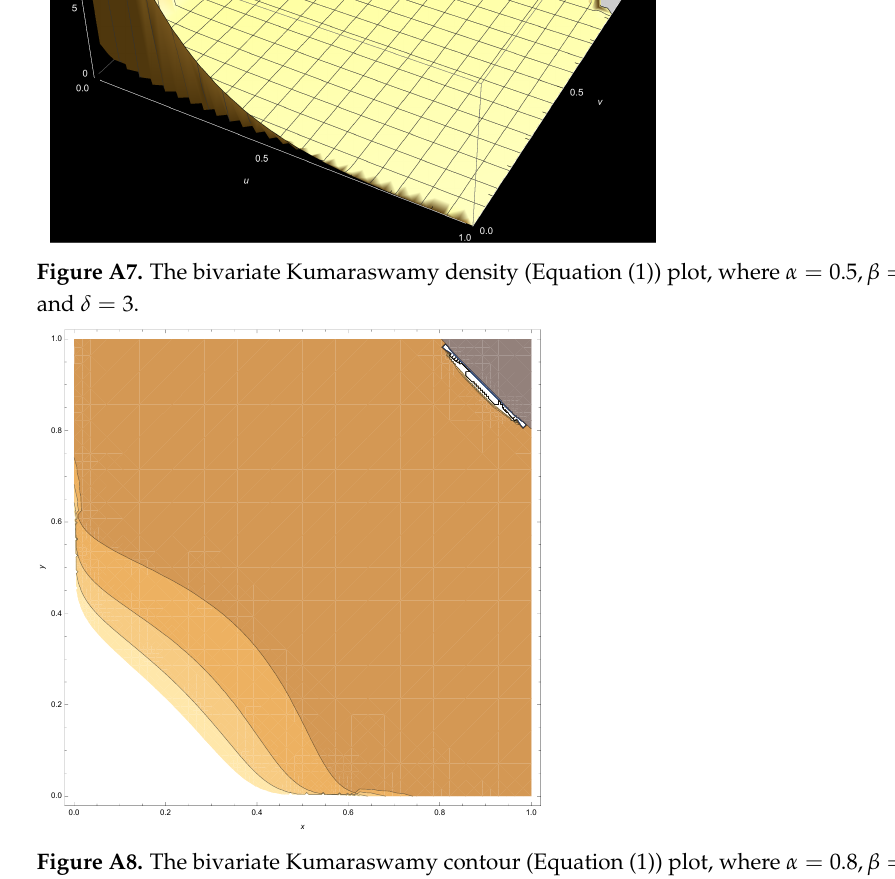
Figure A8. The bivariate Kumaraswamy contour (Equation (1)) plot, where α = 0.8, β = 0.8, θ = 1.2 and δ = 3.